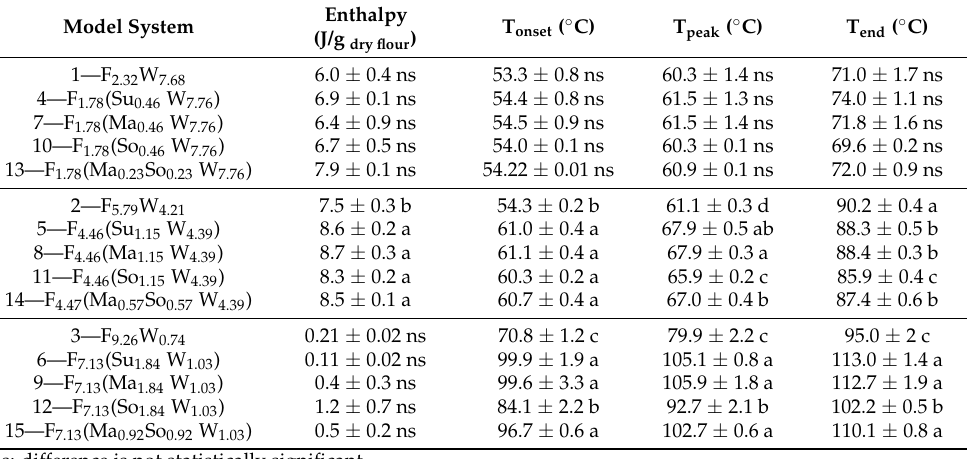
Table 6. Starch gelatinization enthalpy (J/g dry flour) and temperatures ( ◦ C) ( n = 3). Different letters within the same column for the same water content reflect significant differences (Duncan test, α = 5%).